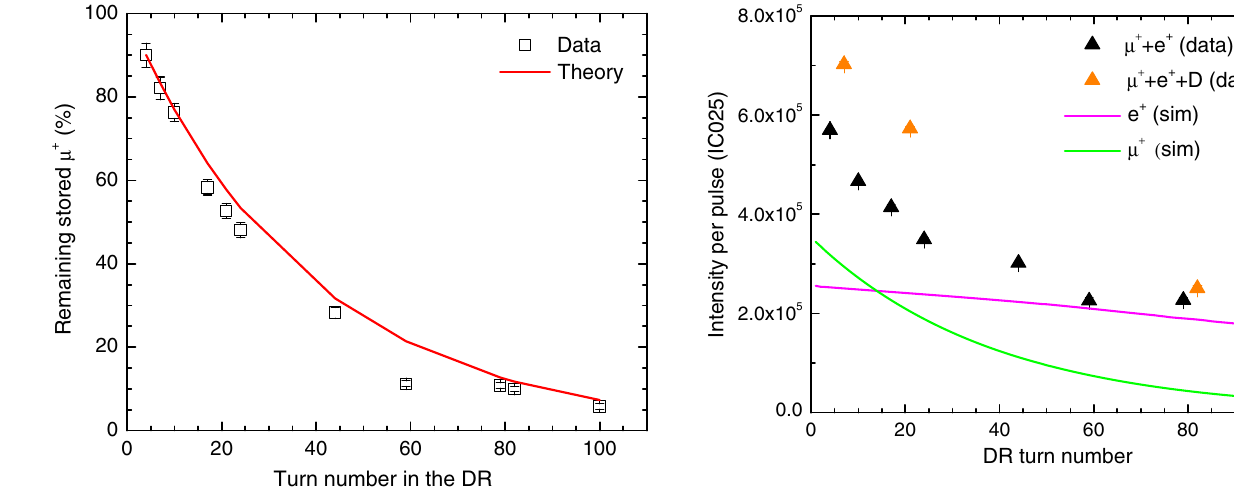
FIG. 10. Percentage of stored muons in the storage ring of the Muon g − 2 experiment versus the number of turns in the DR. The red curve shows the number of stored muons from the exponential decay law.